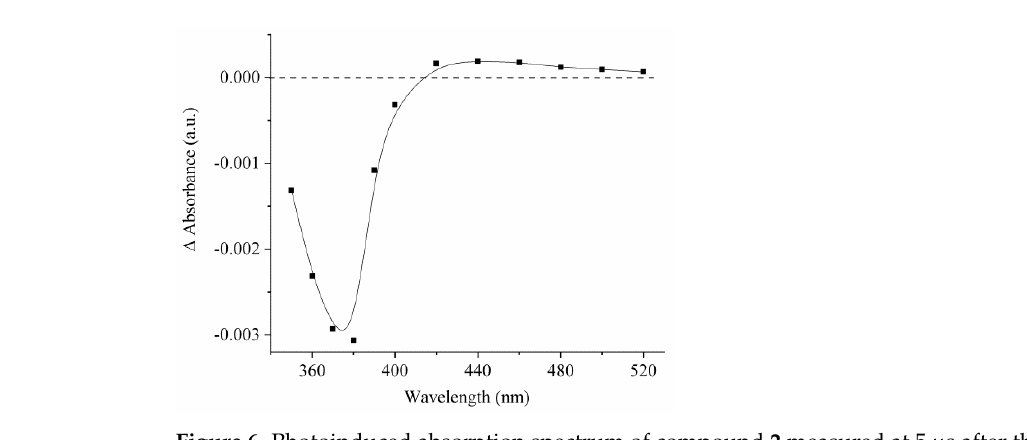
( b ) Figure 5. Kinetic curves of the absorbance change in the deoxygenated solution of compound 1 measured at λ = 400 nm ( a ) and 570 nm ( b ). The concentration of compound 1 was 5 × 10 − 5 mol/L.